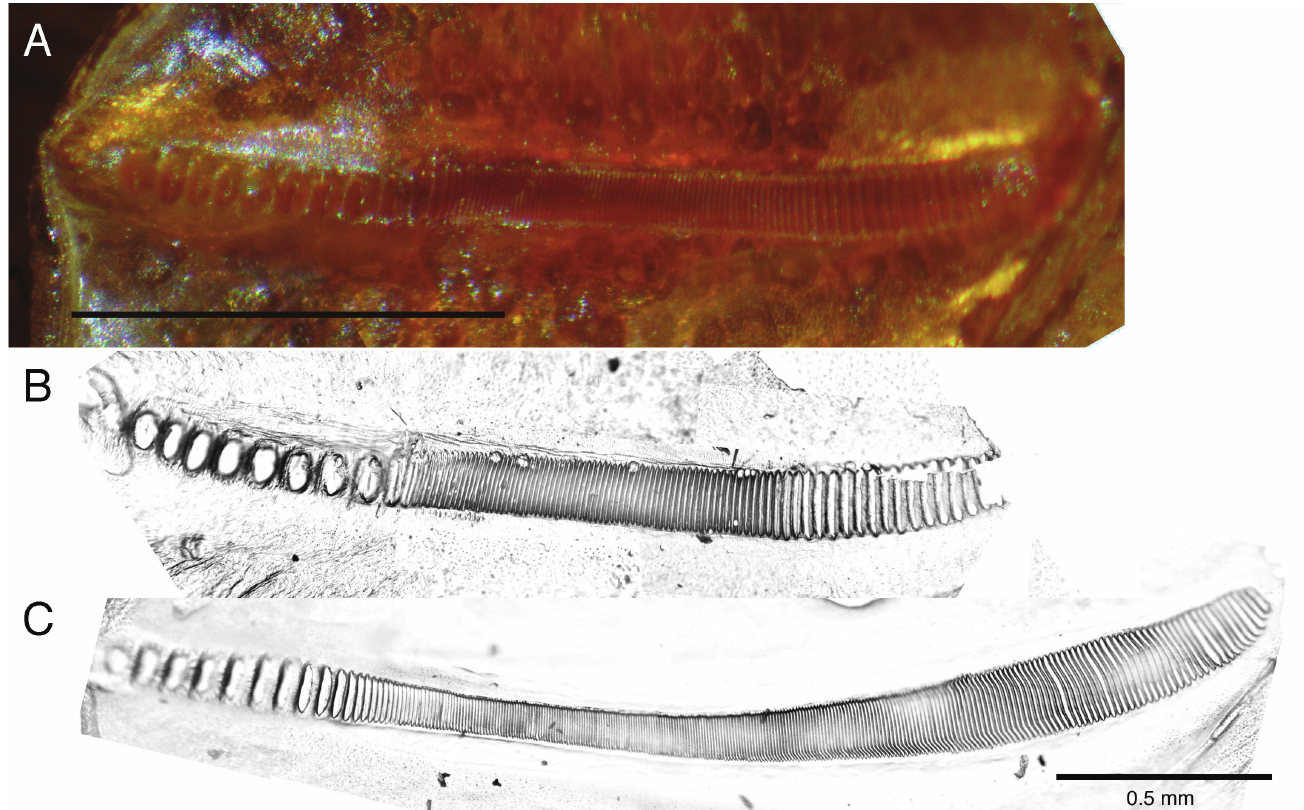
Figure 3. Stridulatory file of E. diuturna sp. n. and E. fulva (articulation of tegmen to the right). A. File of E. diuturna sp. n. on the un- derside of left male tegmen. Scale 1 mm. B–C. Replica of the file of B. E. diuturna sp. n. in comparison to that of C. E. fulva .